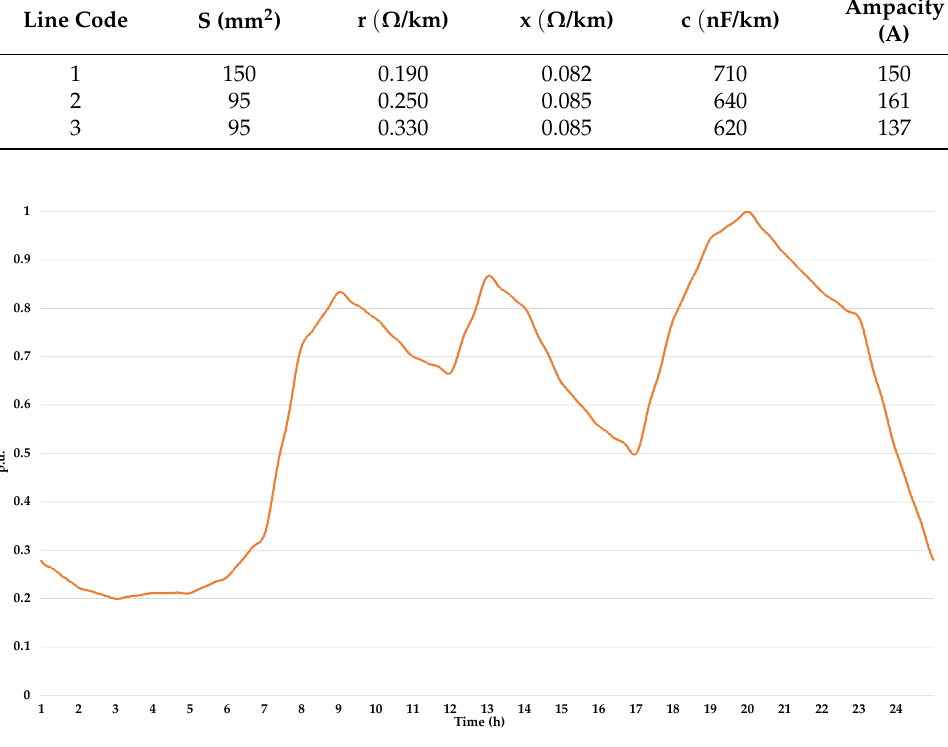
Table 3. Conductor data.